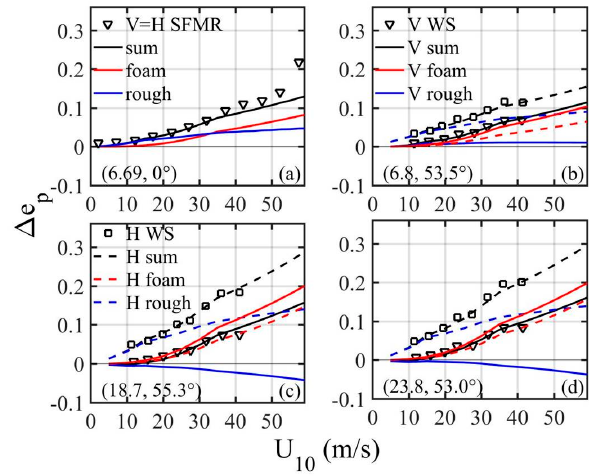
Figure 1. Calculated Δ e H and Δ e H at various microwave frequencies and incidence angles, and comparison with field data: ( a ) 6.69 GHz SRMR, ( b ) 6.8 GHz WindSat, ( c ) 18.7 GHz WindSat, and ( d ) 23.8 GHz WindSat. Sum, foam and roughness contributions are given by black, red and blue curves, solid and dashed lines show vertical and horizontal polarizations, respectively; the two numbers in parentheses are frequency (in GHz) and earth incidence angle (EIA). Reproducing part of ([21], Figure 1).